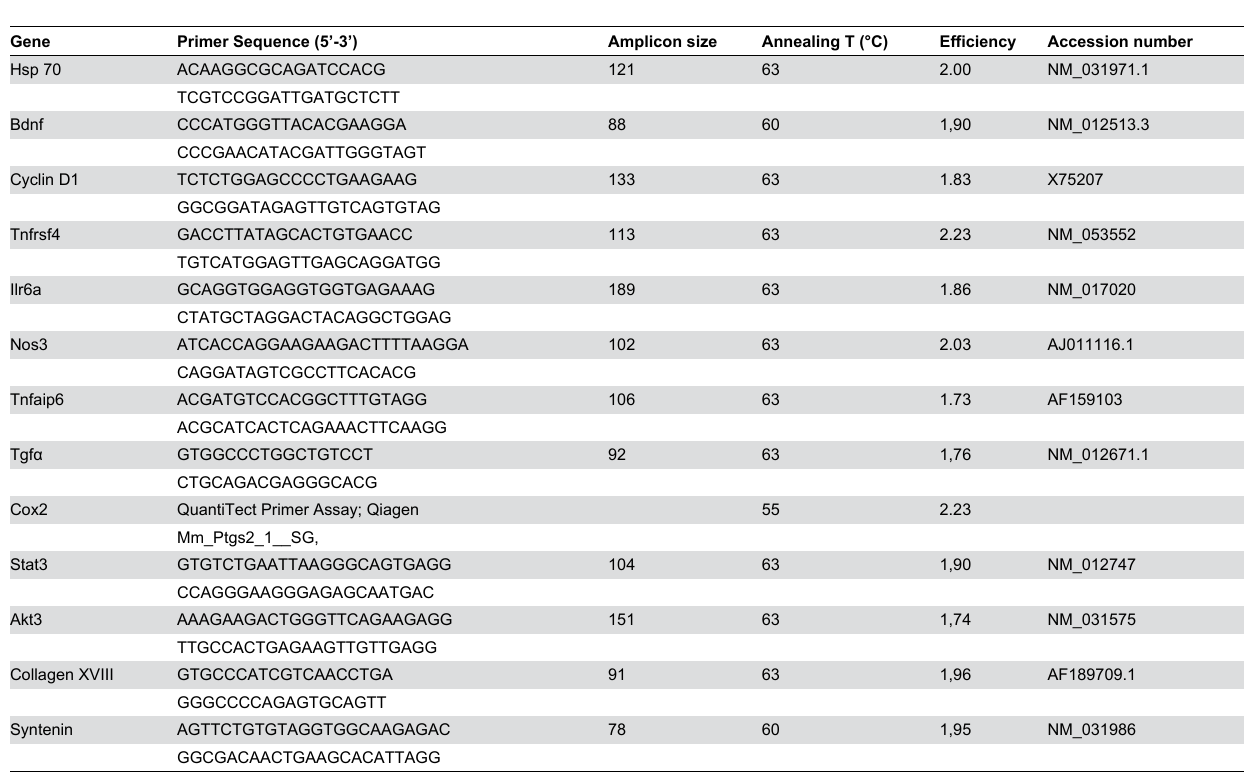
Table 1. Primer sequences, amplicon size and annealing temperature for the candidate genes.